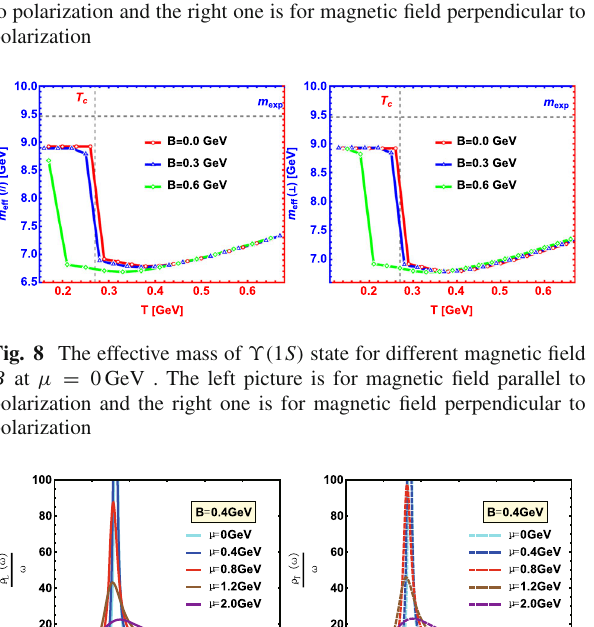
Fig. 5 The spectral function of the J /(cid:2) state for different temperature T . The left picture is for magnetic field parallel to polarization and the right one is for magnetic field perpendicular to polarization